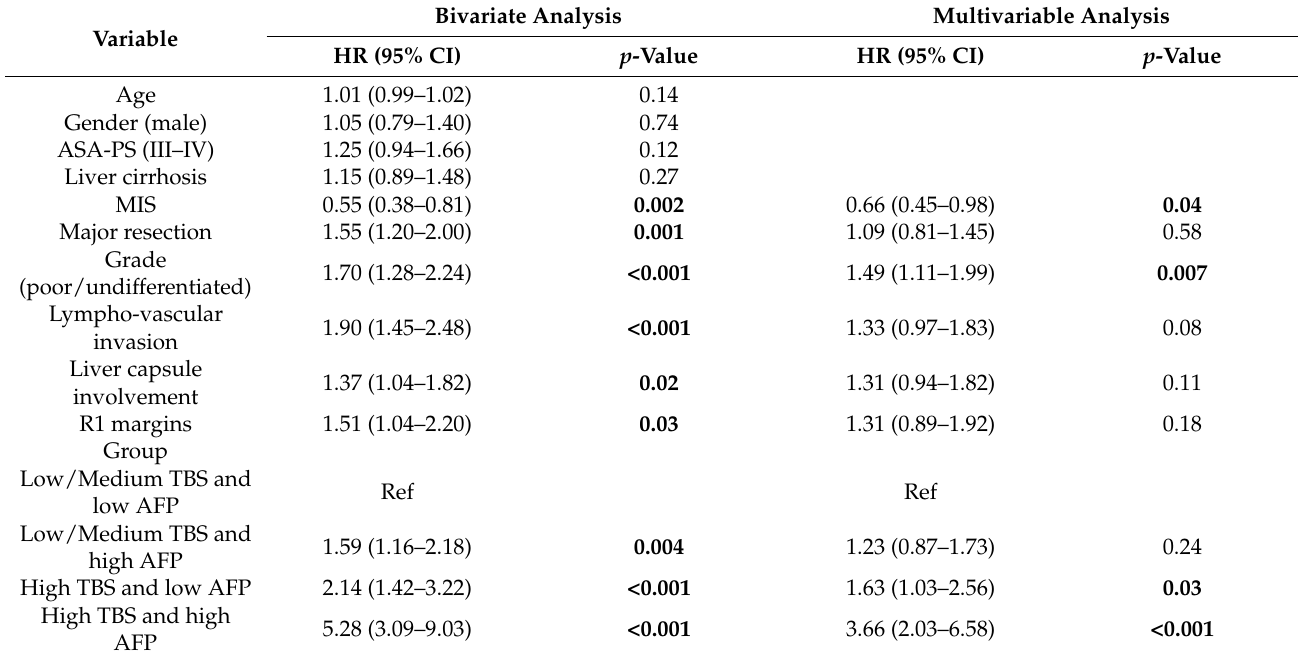
Table 3. Cox regression analysis of factors associated with overall